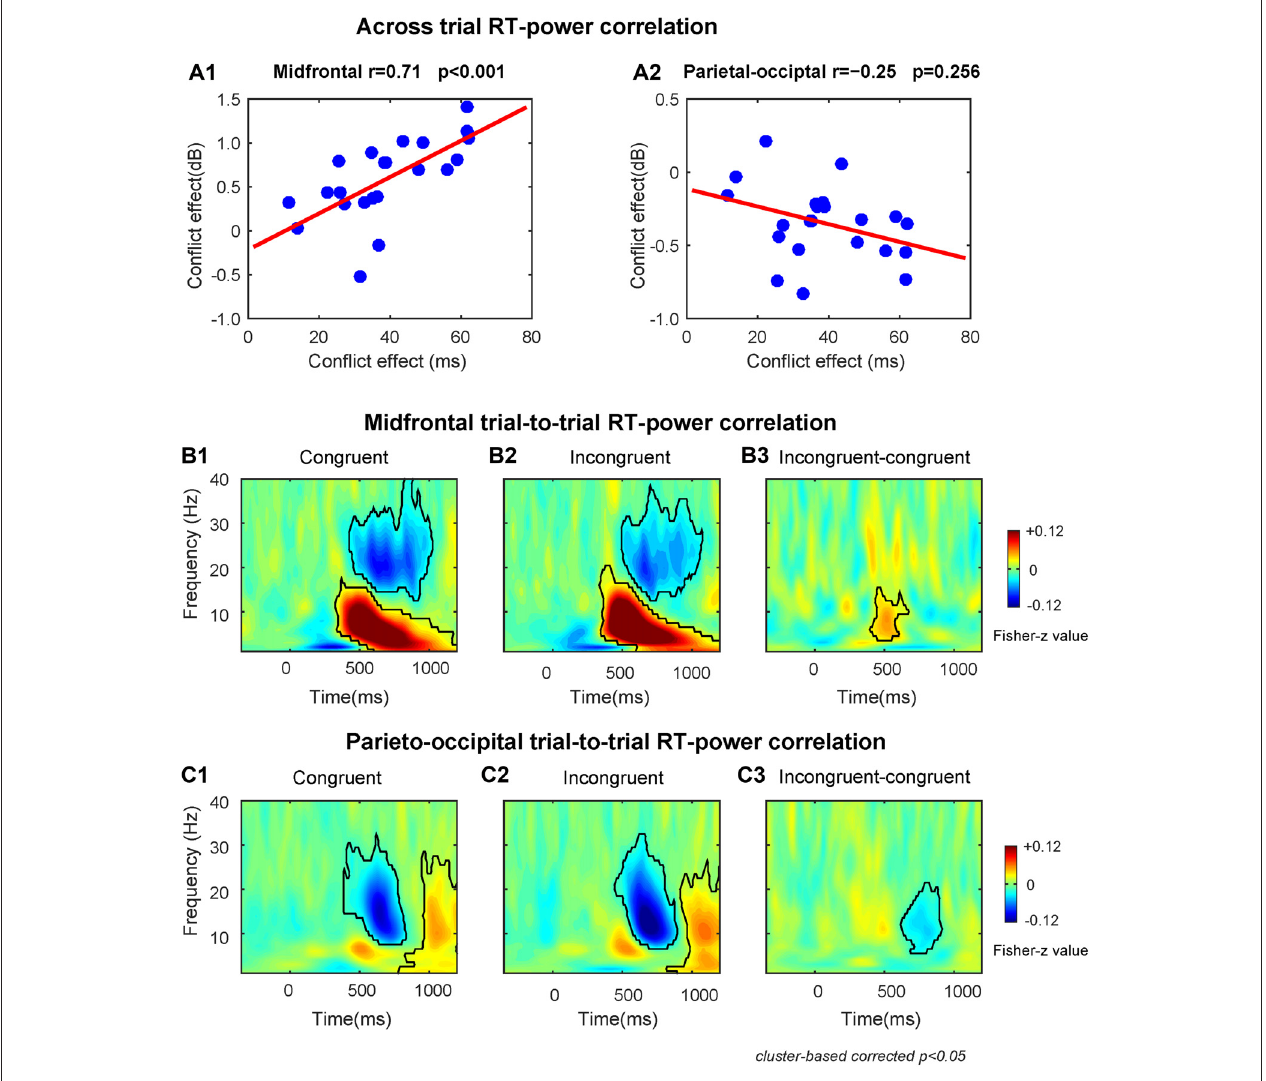
FIGURE 3 | The results of RT-power correlations. (A1) The midfrontal theta power was significantly positively correlated with the conflict effect on RT. (A2) The correlation between parieto-occipital alpha power and the conflict effect on RT was not significant. The TF plots for the correlation between single-trial RT and single-trial power on congruent (B1) and incongruent (B2) conditions and the conflict effect on correlation coefficient (B3) at midfrontal region of interest (ROI) electrodes. The TF plots for the correlation between single-trial RT and single-trial power on congruent (C1) and incongruent (C2) conditions and the conflict effect on correlation coefficients (C3) at parieto-occipital ROI electrodes. Each pixel in TF plots (panels B1–3,C1–3 ) represent the Fisher-Z transformed Spearman correlation coefficient. Black contours in TF plots outline regions that are statistically significant at p < 0.05 and corrected for multiple comparisons using cluster based statistical